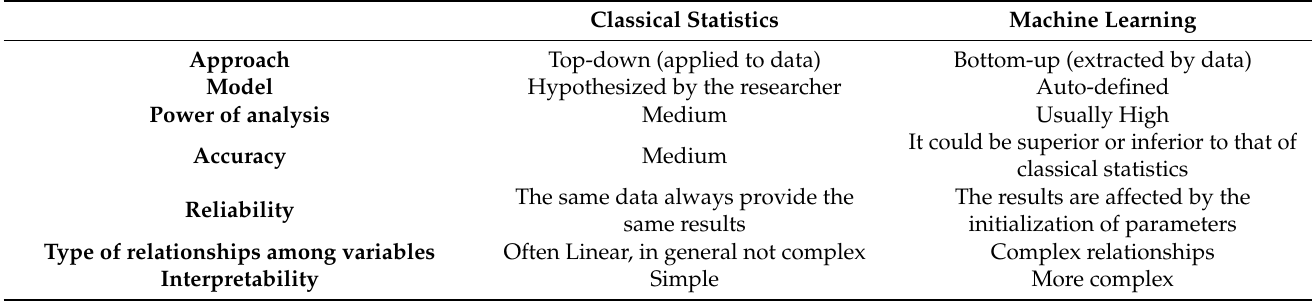
Table 1. Comparison between classical statistics and machine learning methods. Classical Statistics Machine Learning Approach Top-down (applied to